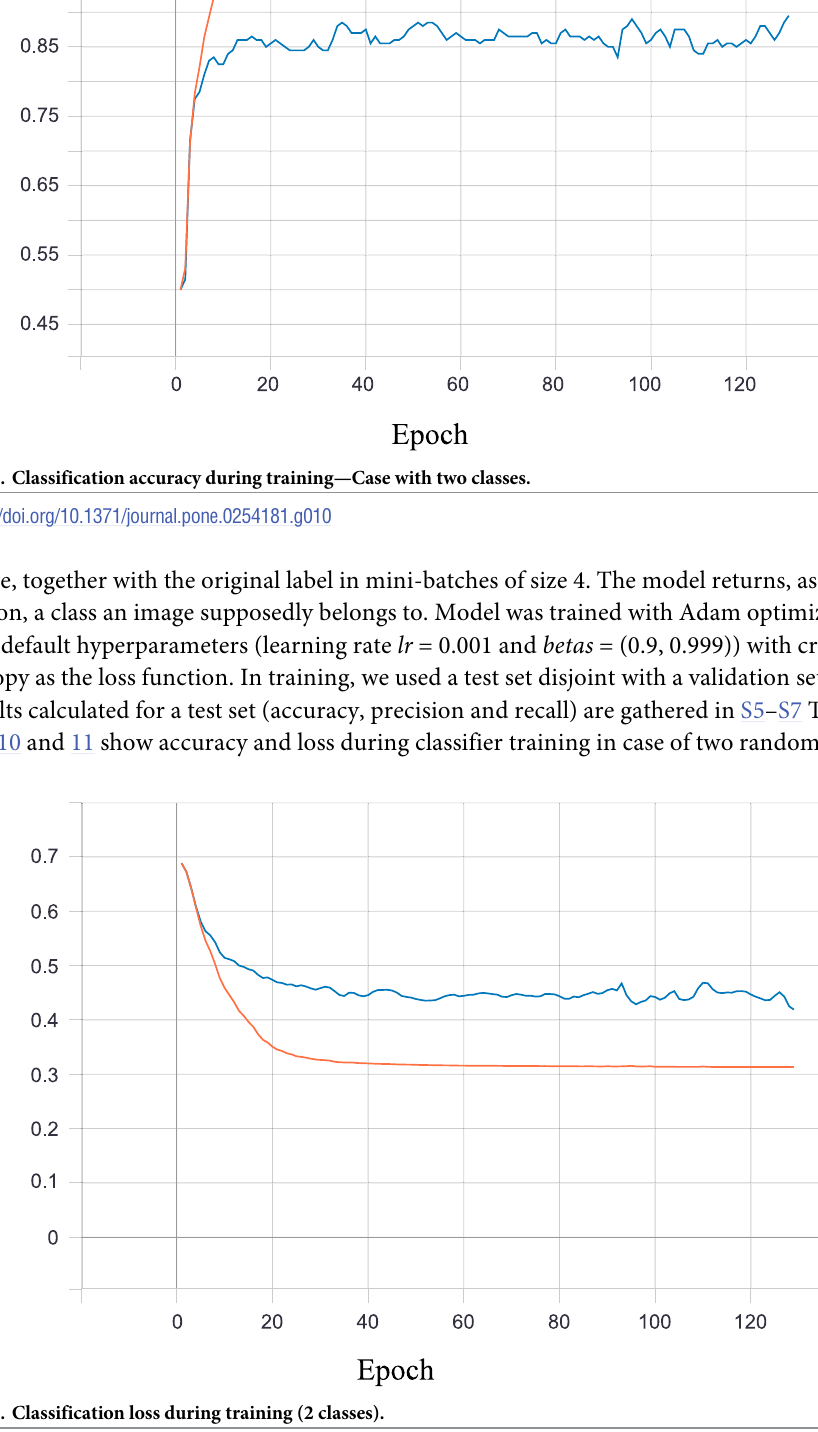
Fig 11. Classification loss during training (2